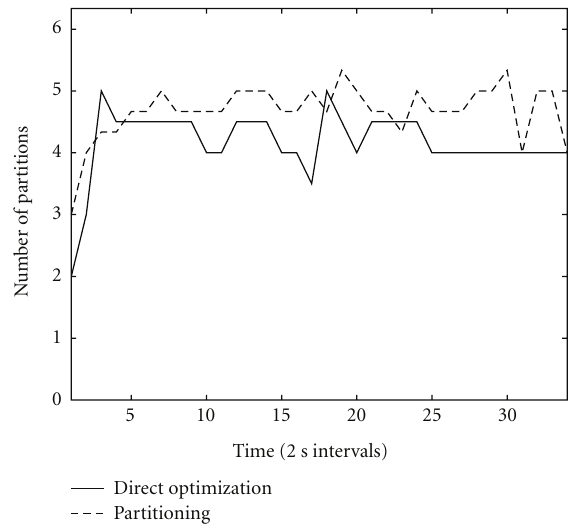
Figure 16: Comparison of sample mean number of search and tracking partitions over simulation time between state-of-the-art direct distribution optimization and partition learning classifica- tion path planning